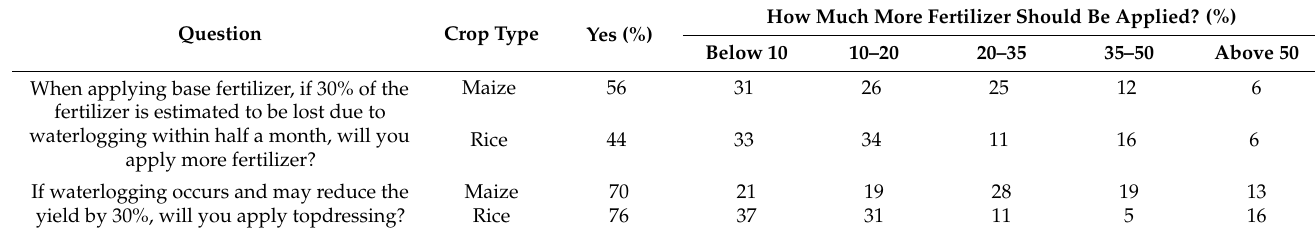
Table 9. Waterlogging disasters and farmers’ fertilizer application